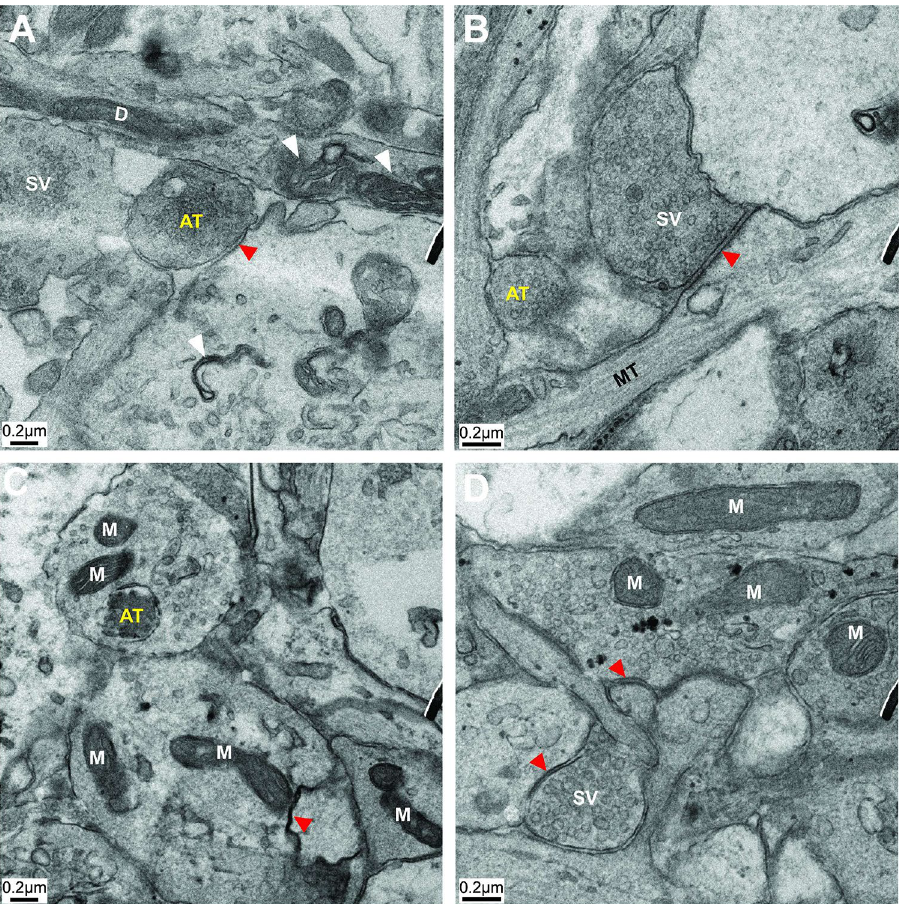
Figure 9. Representative electron micrographs of synapses from male ( A , B ) and female ( C , D ) hippocampal area CA1. Axon terminal (AT), Dendritic spine (D), Mitochondria (M), Synaptic Vesicle (SV), Microtubules (MT), Myelin sheaths (white arrow), Postsynaptic densities (red arrow). Scale bar: 0.2